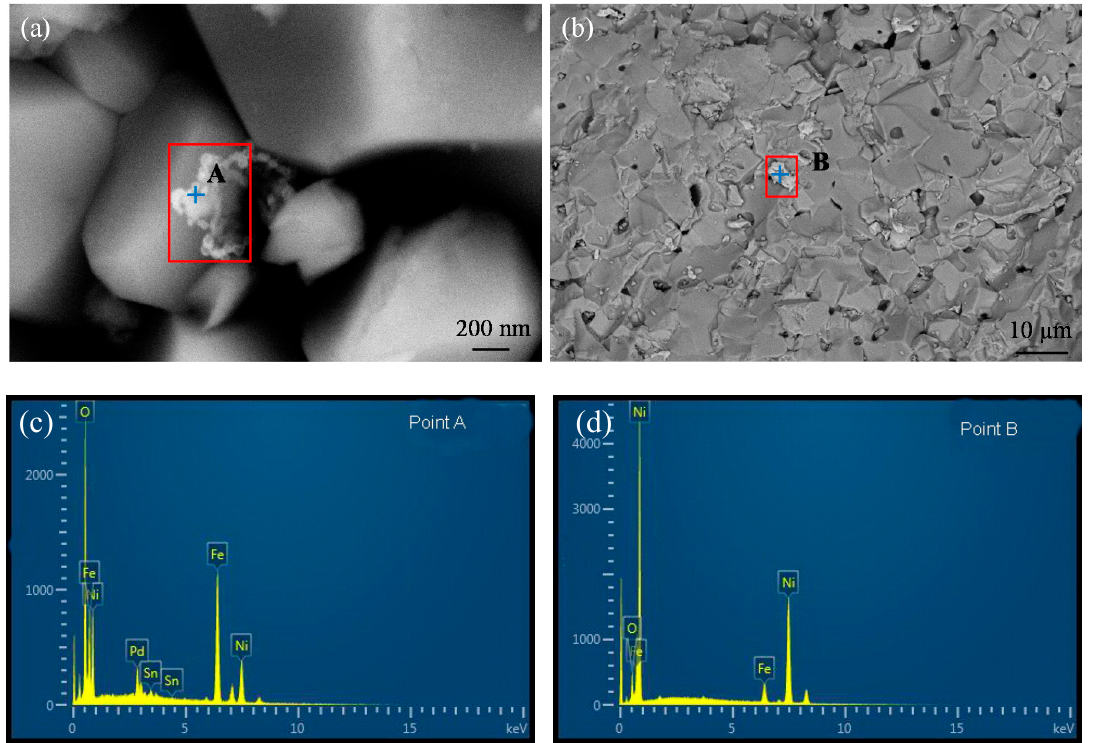
Figure 1. SEM images of ( a ) Pd activated NiFe 2 O 4 particles, ( b ) Ni-NiFe 2 O 4 particles, and EDS results of ( c ) at point A, ( d ) at point B.